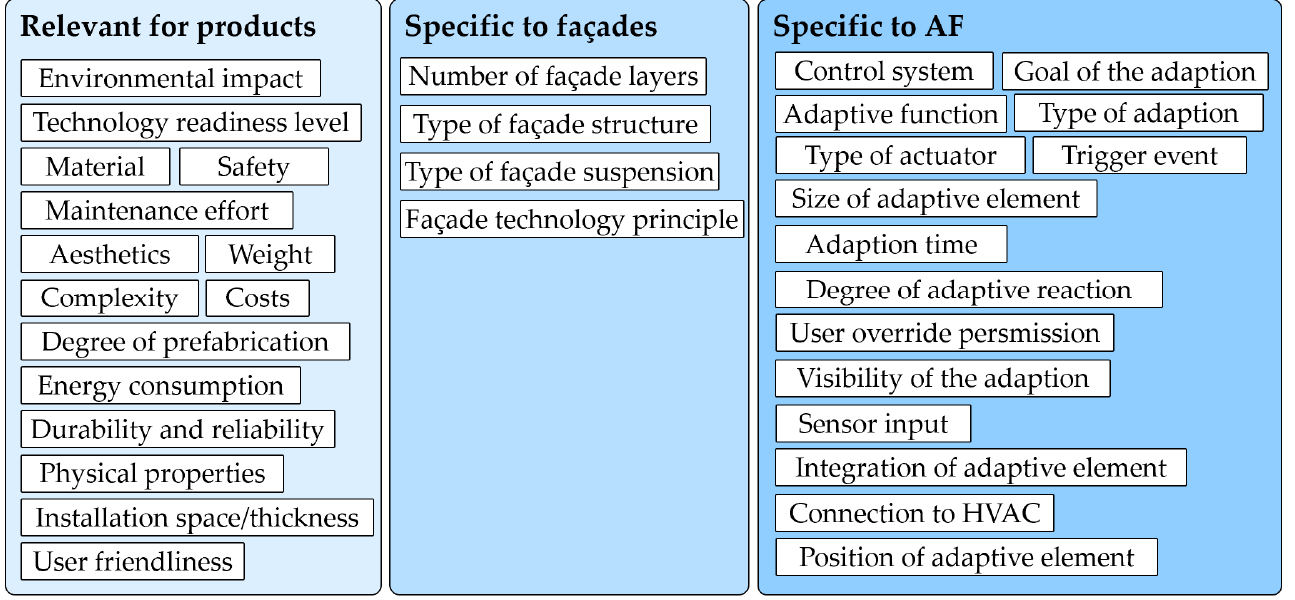
Figure 8. Differentiation between characteristics relevant for products in general, characteristics relevant for conventional façades, and AF-speci fi c characteristics.